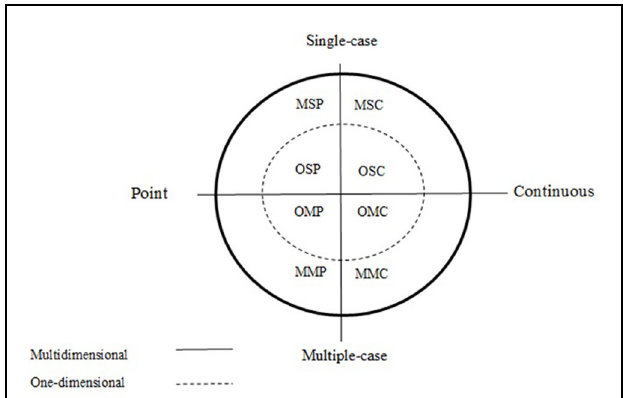
FIGURE 1 | A classification system for gathering data via observation. The acronyms of the figure correspond to the initials of the levels of the three components: behavior (multidimensional or one-dimensional), participant (single-case or multiple-case), and time (point or continuous),